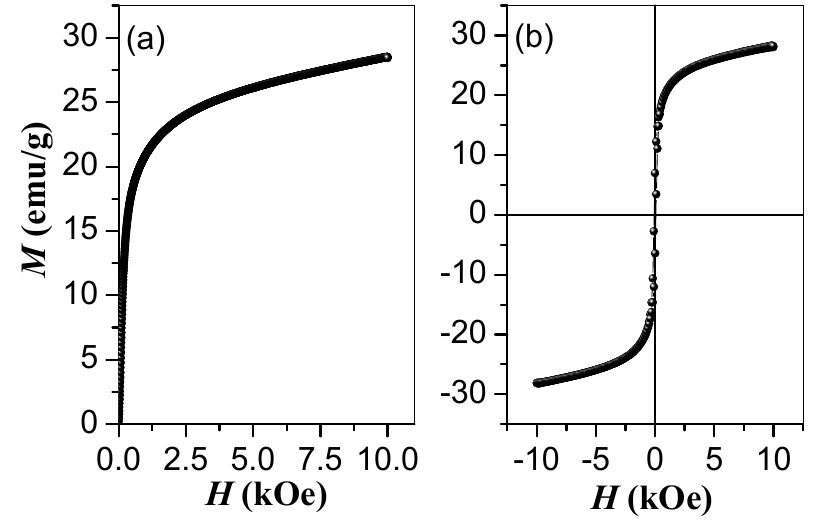
Figure 5. Initial magnetization curve ( a ), and hysteresis loop ( b ) of the ZnFe 2 O 4 spinel ferrites. Table 1. Magnetic parameters and range of particle diameters for the ZnFe 2 O 4 sample.